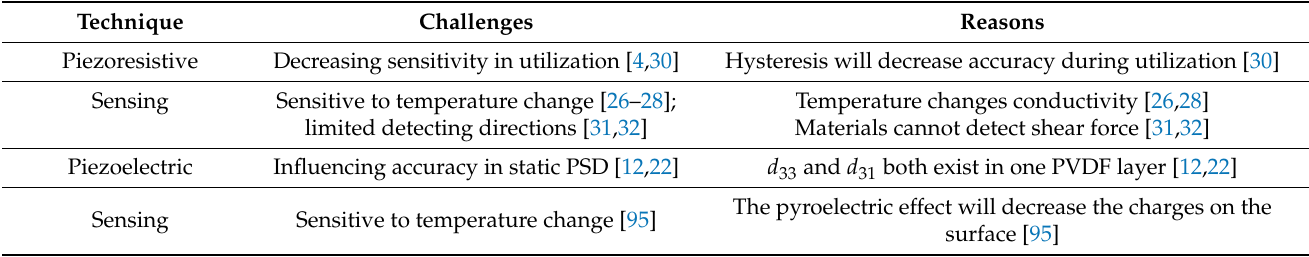
Table 4. A comparison of challenges and correspondent reasons of two